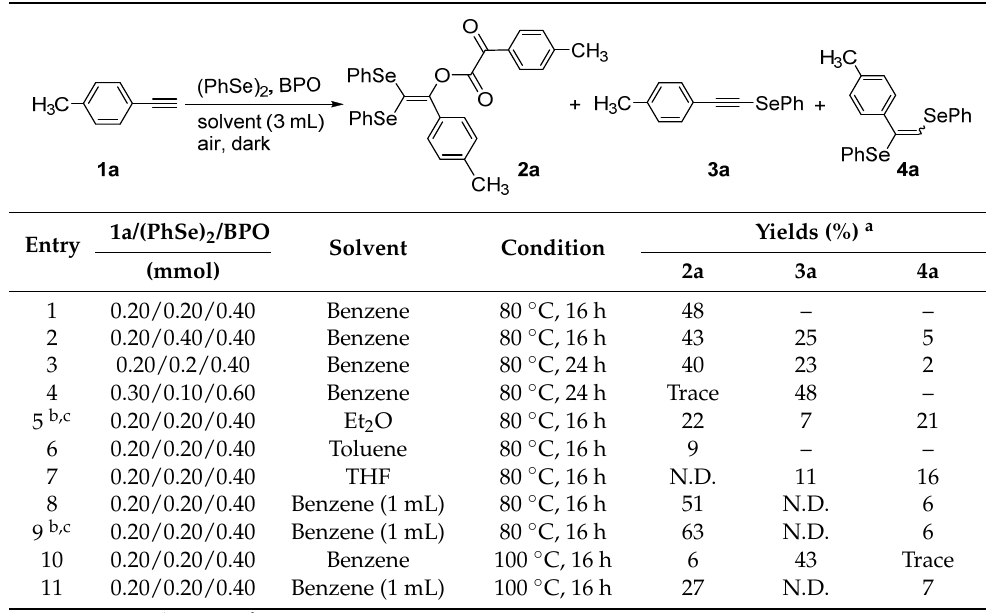
Table 1. Optimization of the reaction conditions for the synthesis of 2a .